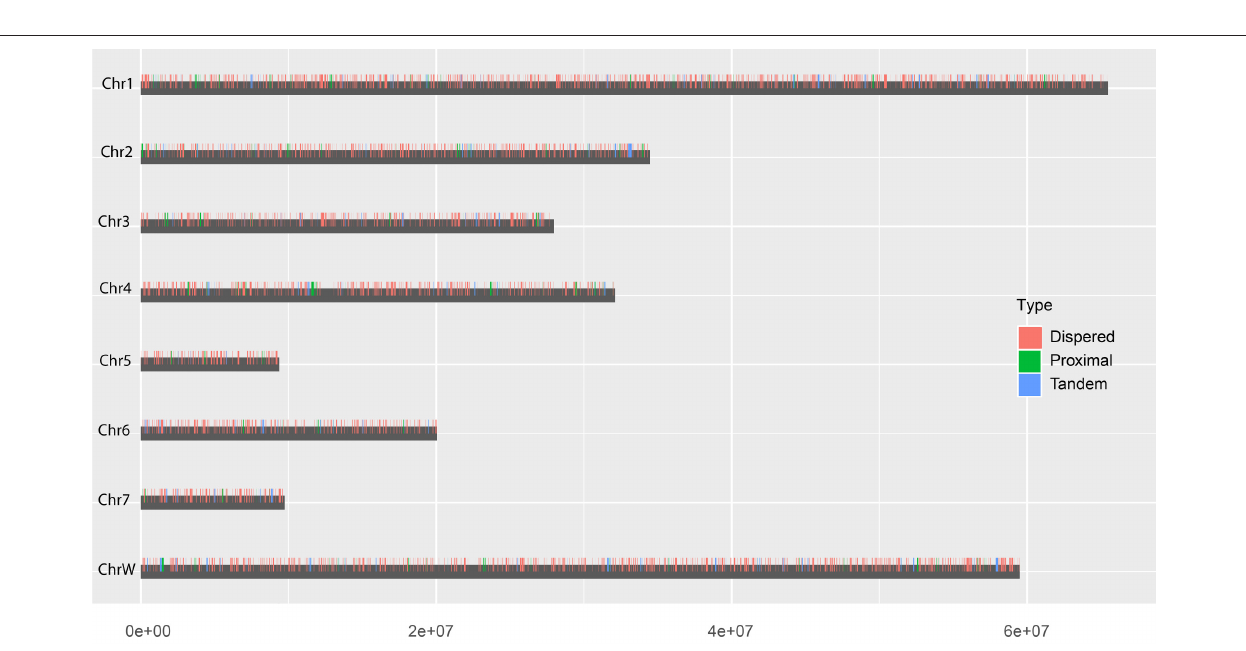
FIGURE 4 | Chromosomal locations of each duplication type. The vertical bars indicate the locations of dispersed (red), proximal (green) and tandem (blue)duplications in